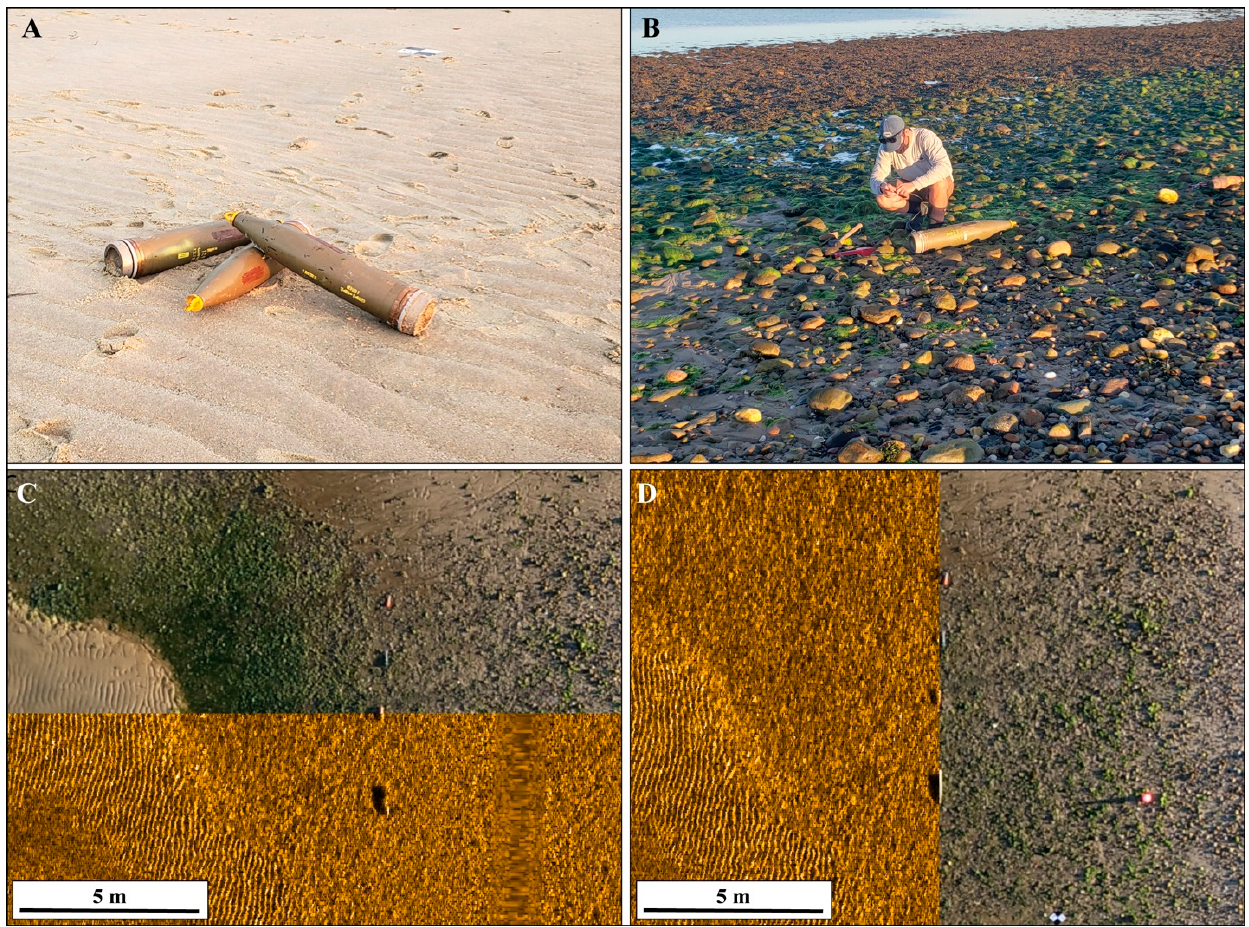
Figure 1. ( Left ) Site 1: sandy intertidal area in Provincetown Harbor. Inset locus map. ( Right ) Site 2: mixed sand and gravel beaches with predominantly cobble bottom. Yellow boxes are approximate locations of surveys.